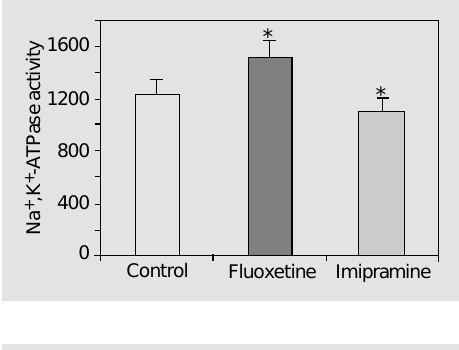
Figure 1. Effect of chronic ad- ministration (daily injections of 10 mg/kg for 14 days) of imipra- mine and fluoxetine on Na + ,K + - ATPase activity in synaptic plasma membrane from rat ce- rebral cortex. Enzyme specific activity is reported as nmol Pi min -1 mg protein -1 . Data are re- ported as means ± SD for seven animals in each group. *P<0.05 compared to control (Duncan multiple range test). Figure 2. In vitro effect of fluox- etine on Na + ,K + -ATPase activity in synaptic plasma membrane from rat cerebral cortex. Enzyme specific activity is reported as nmol Pi min -1 mg protein -1 . Data are reported as means ± SD for seven animals in each group. *P<0.01 compared to control (Duncan multiple range